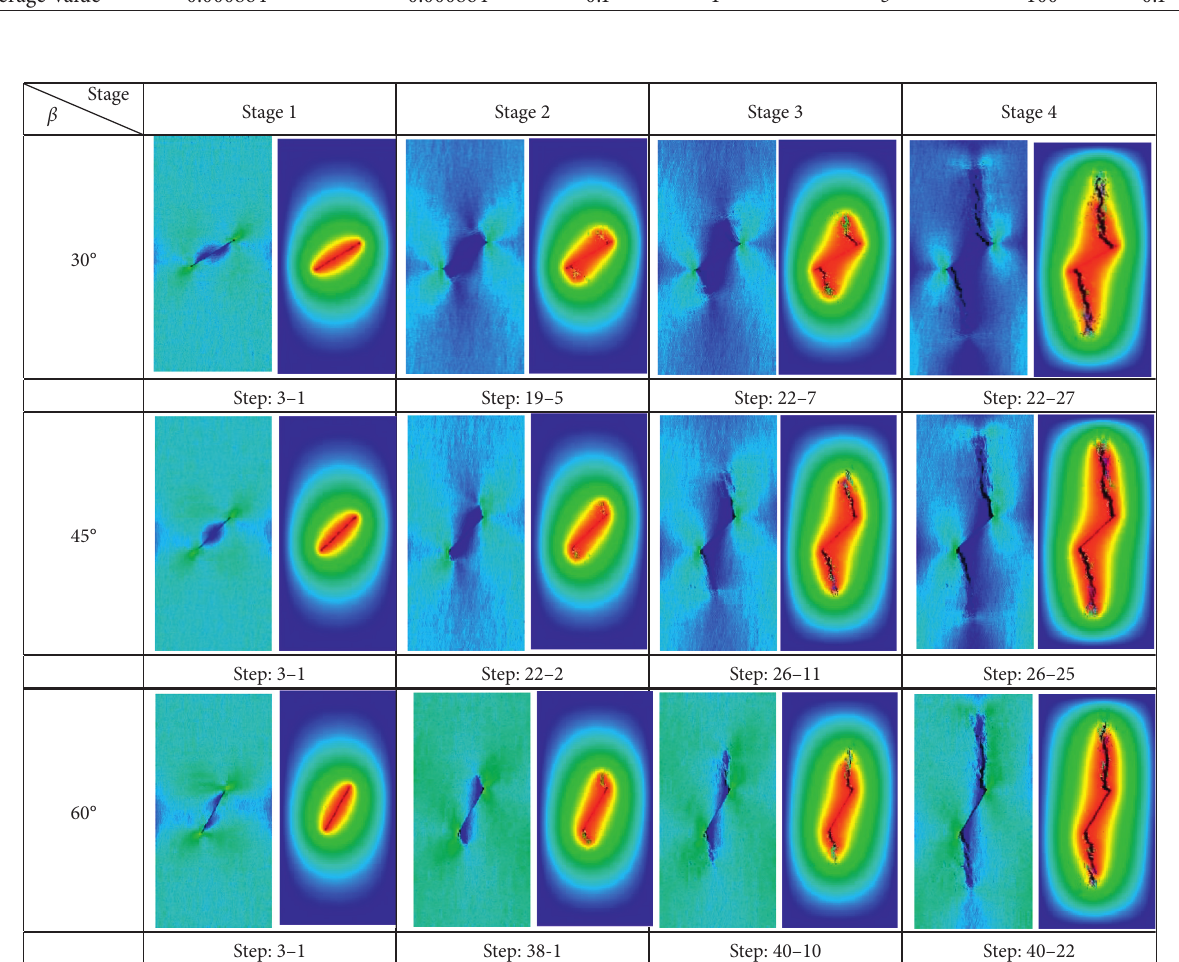
Figure 3: Evolution of crack propagation and seepage pore water pressure under uniaxial